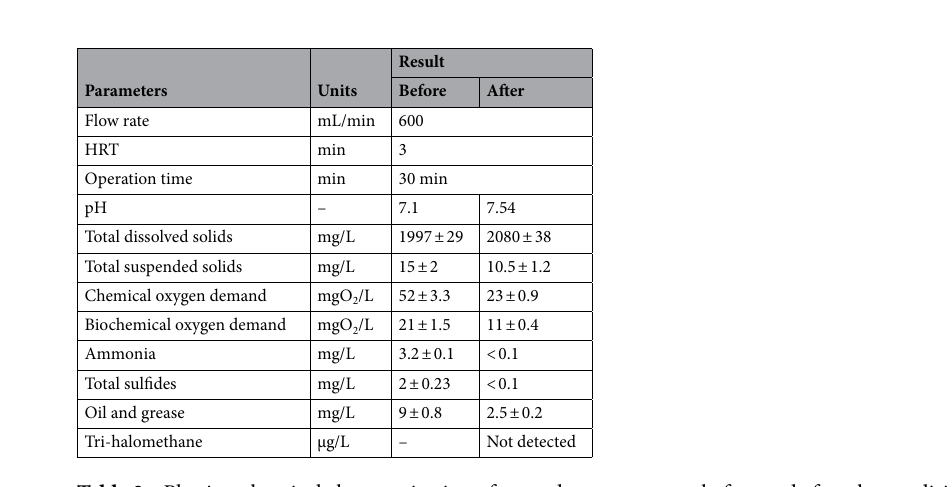
Table 2. Physico-chemical characterization of secondary wastewater before and after electro-disinfection.